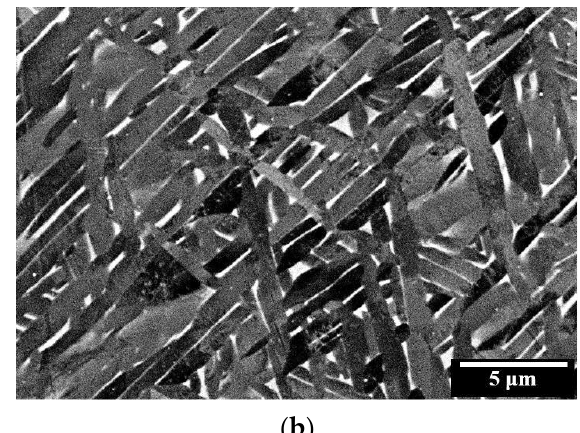
Figure 11. ( a ) Typical SEM micrograph of the heat-treated titanium femoral stem produced via DPF showing the α + β lamella microstructure; ( b ) Higher magnification showing the fine lamella mor- phology. Table 4. Average HRC hardness of the as-forged and heat-treated conditions for each region of in- terest of the Ti-6Al-4V DPF ELI hip component.